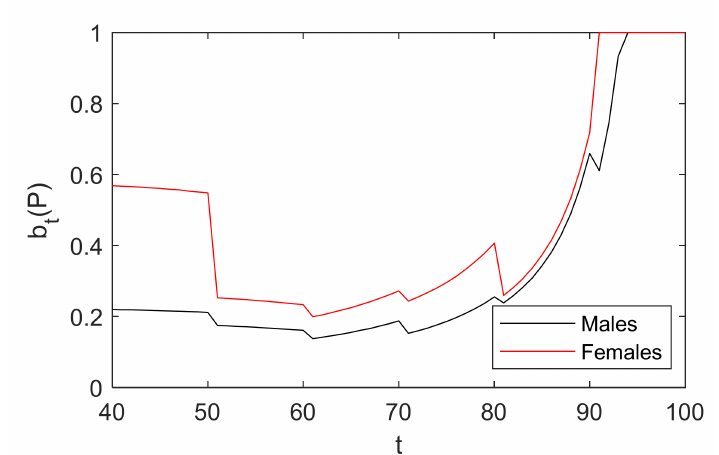
Figure 5. The threshold affected by individual